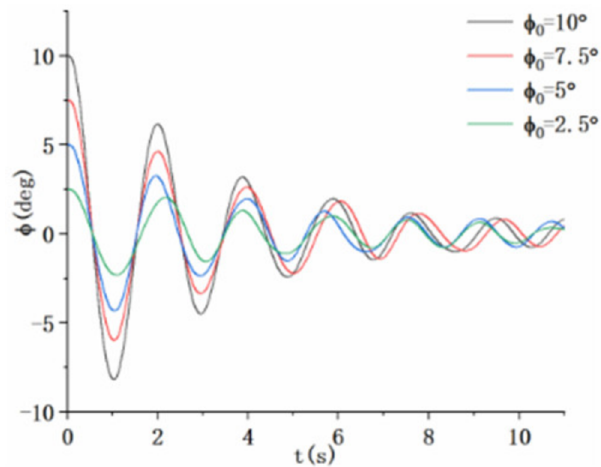
Figure 4. The roll attenuation curves.